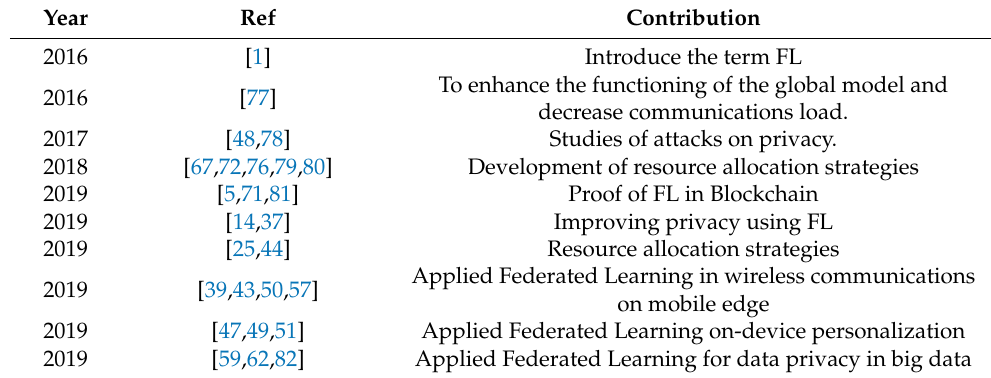
Table 3. Year-wise contribution to the research of federated